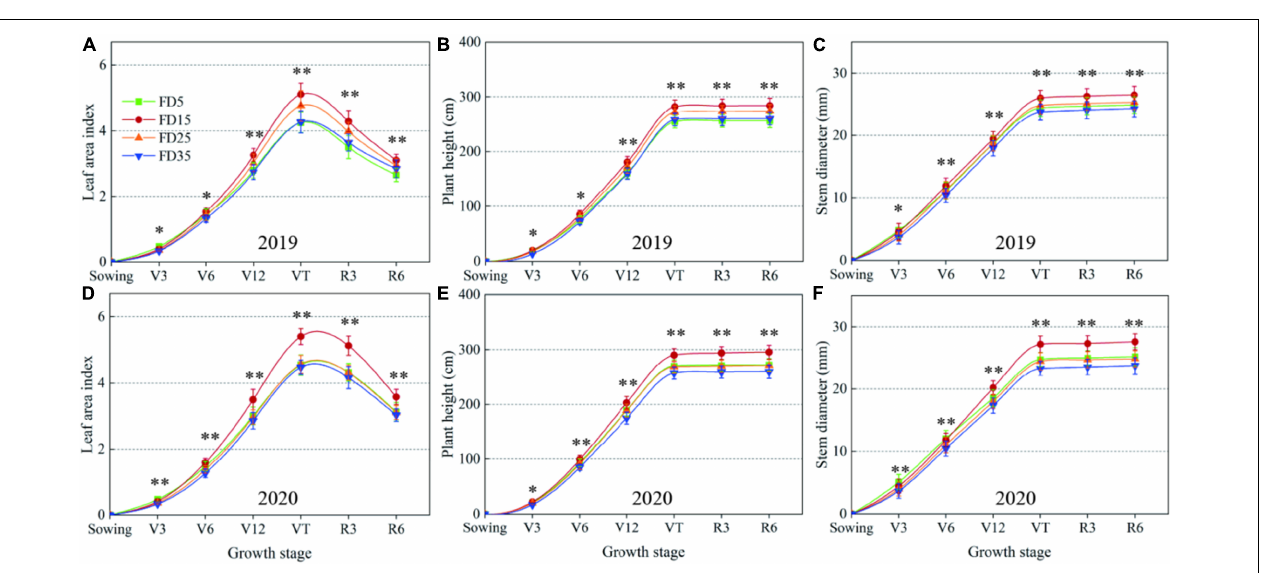
2-year average under FD5, the accumulated dry matter in wheat was 1.1% higher under FD15, but 4.6 and 7.4% lower under FD25 and FD35,